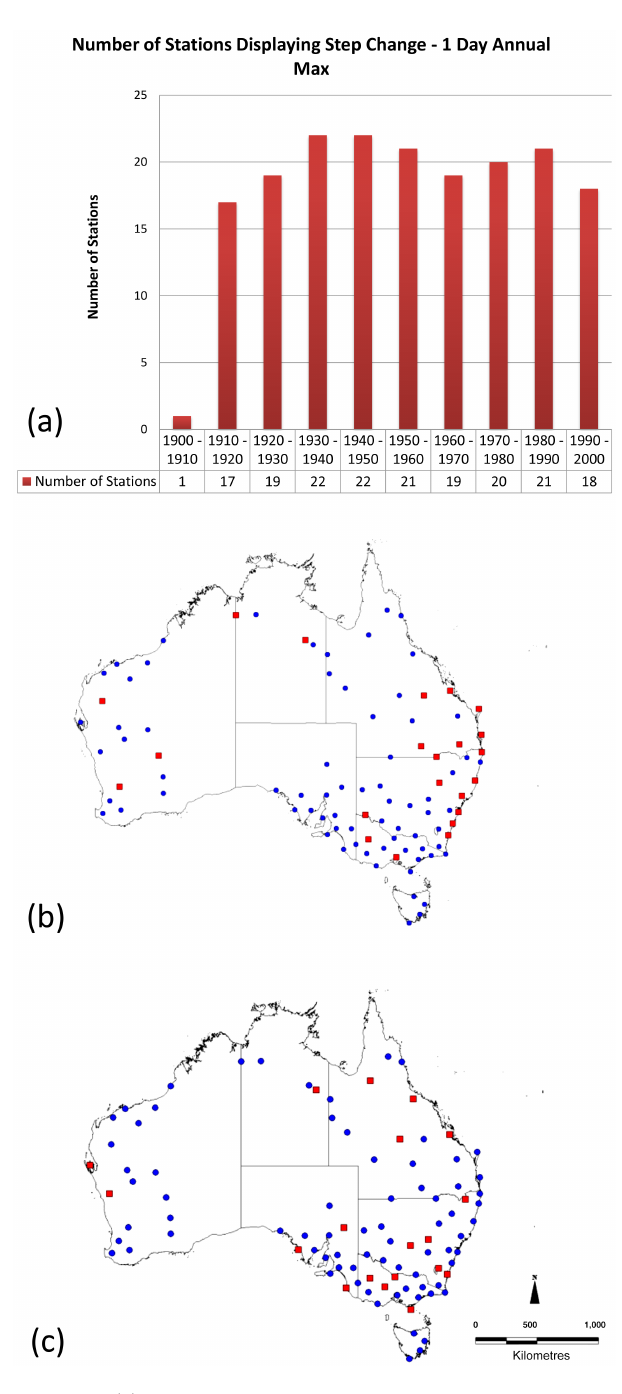
Figure 5. (a) Number of stations in each decade displaying evi- dence of a step change in 1-day annual maximum. (b) Stations (in red) with at least one statistically significant step change in the 1- day annual maximum during 1940–1950 (using the Mann–Whitney U test). (c) Stations (in red) with at least one statistically significant step change in the 1-day annual maximum during 1970–1980 (using the Mann–Whitney U